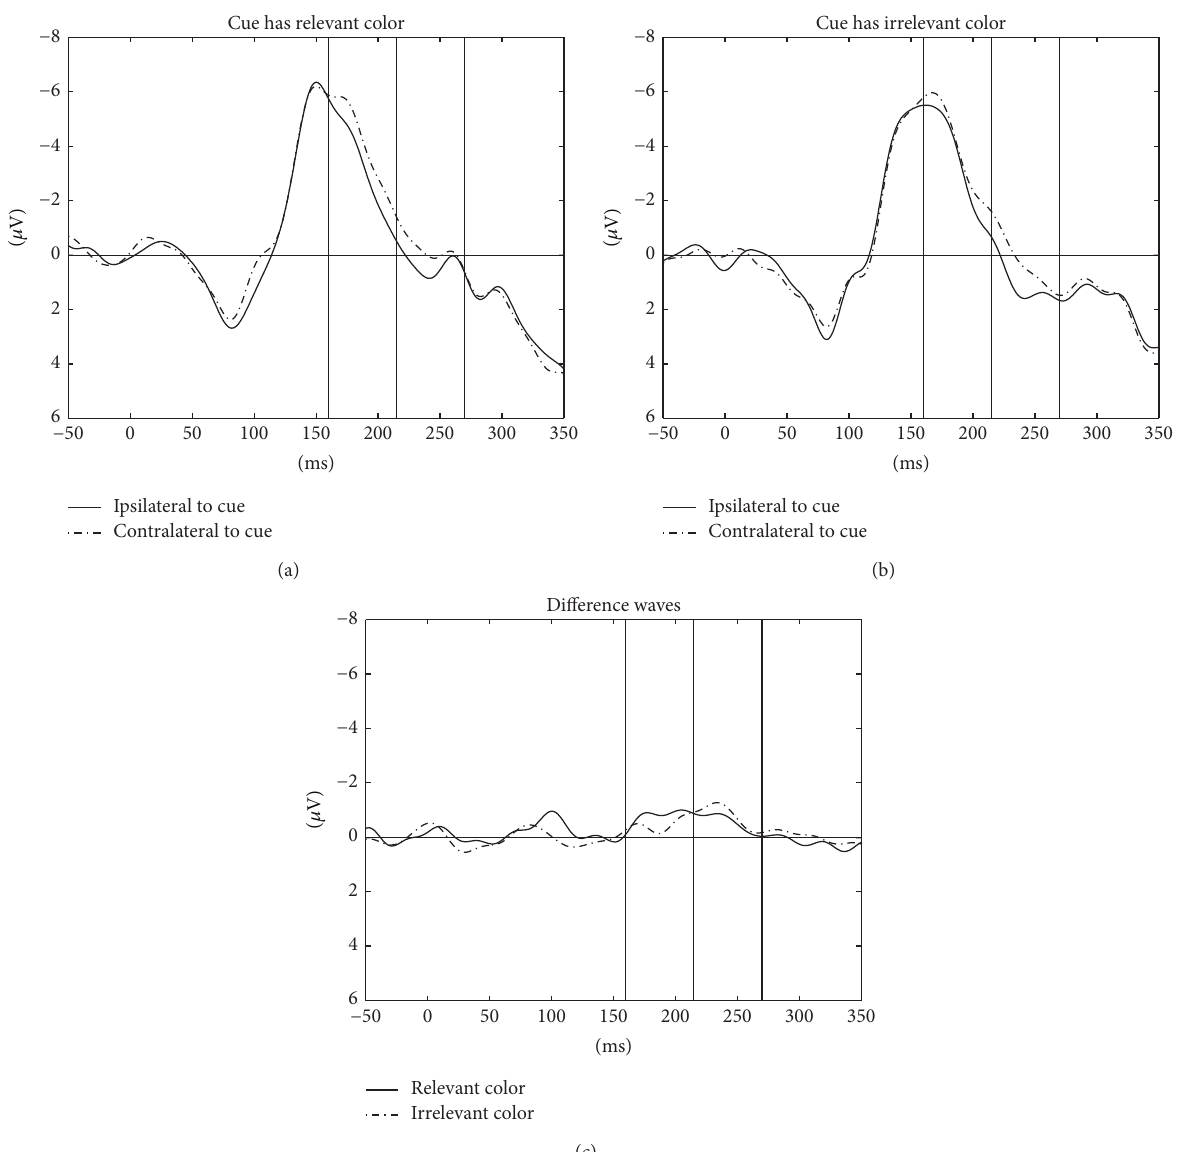
Figure 4: Data from the 50% fastest responses. (a) ERPs (in 𝜇 Volts on the 𝑦 -axis) ipsilateral to the relevant cue (solid lines) and contralateral to the relevant cue (dashed lines), as a function of the time since cue onset (at zero) on the 𝑥 -axis. (b) Same as (a) but for irrelevant cues. (c) Difference waves of contralateral minus ipsilateral activity, separately for relevant cues (solid line) and for irrelevant cues (dashed